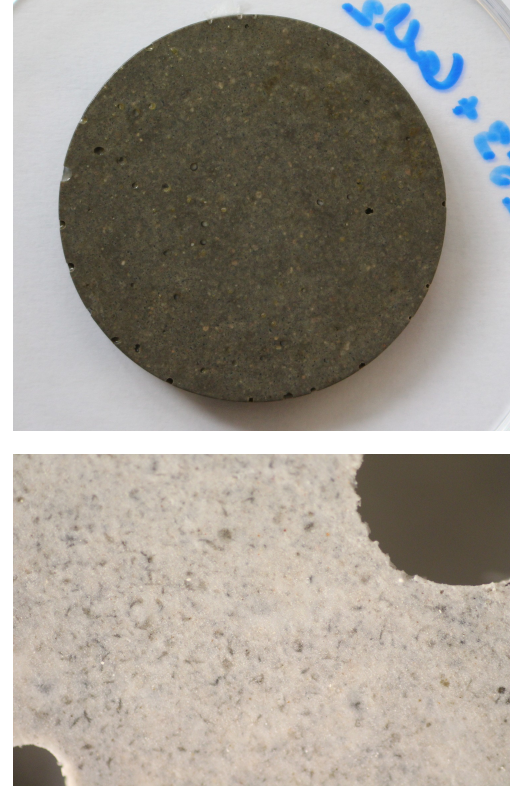
Figure 10. Surface of the specimen placed in solution solution. of bacteria in the water. 2